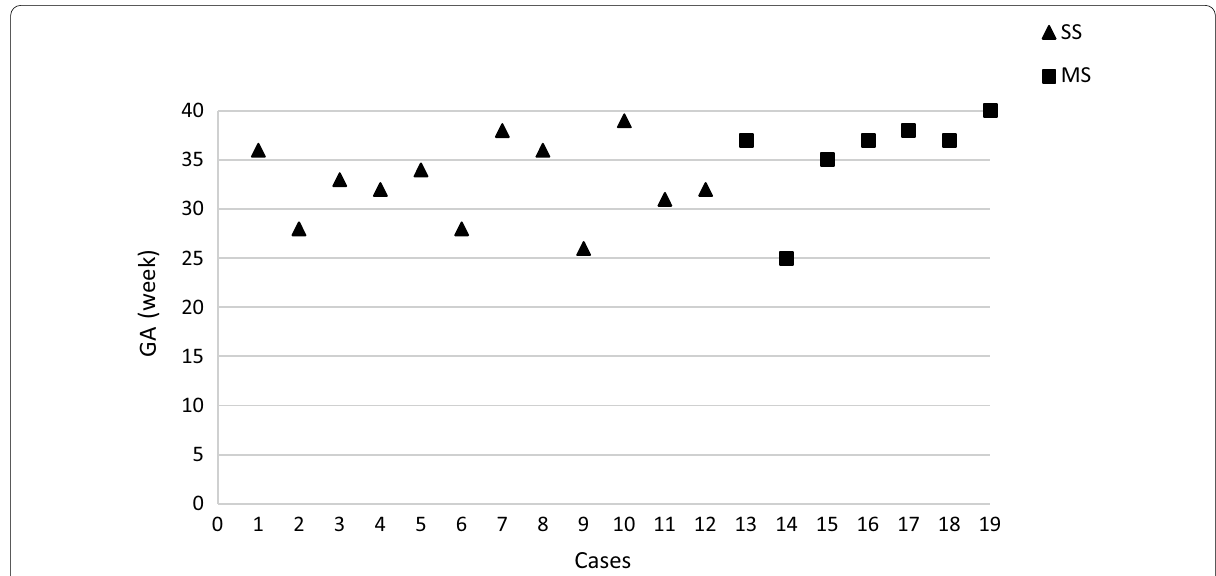
Fig. 4 The gestational age at diagnosis of nineteen cases. Note that all cases were diagnosed in the late second and third trimesters. GA: gestational age at diagnosis; SS: single shunt; MS: multiple shunts